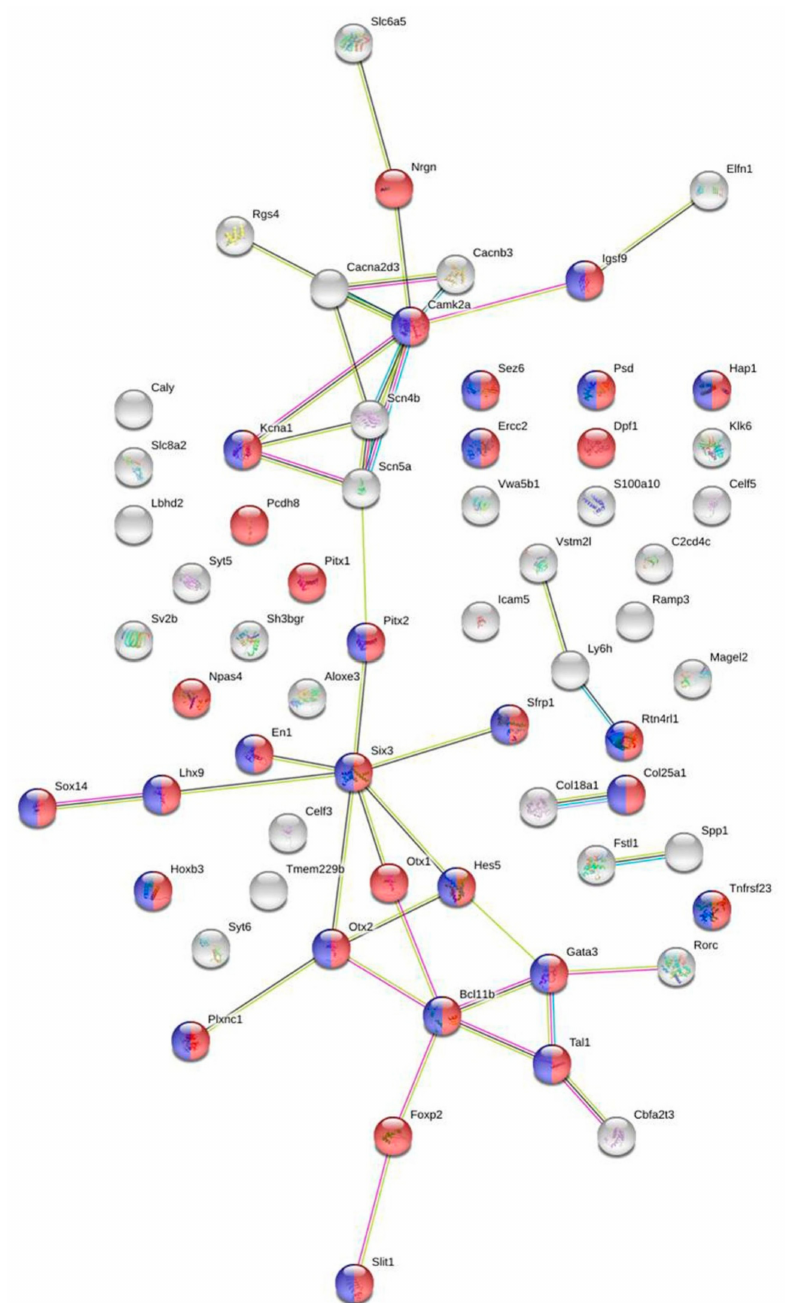
Figure 2. The relationships between DEGs that make the most significant contribution to the intergroup (winners vs. losers) di ff erences according to the PLS-DA analysis. STRING database utilities were used to identify possible associations between encoded proteins. The genes encoding proteins associated with the nervous system development are shown in red; the genes associated with generation of neurons are shown in